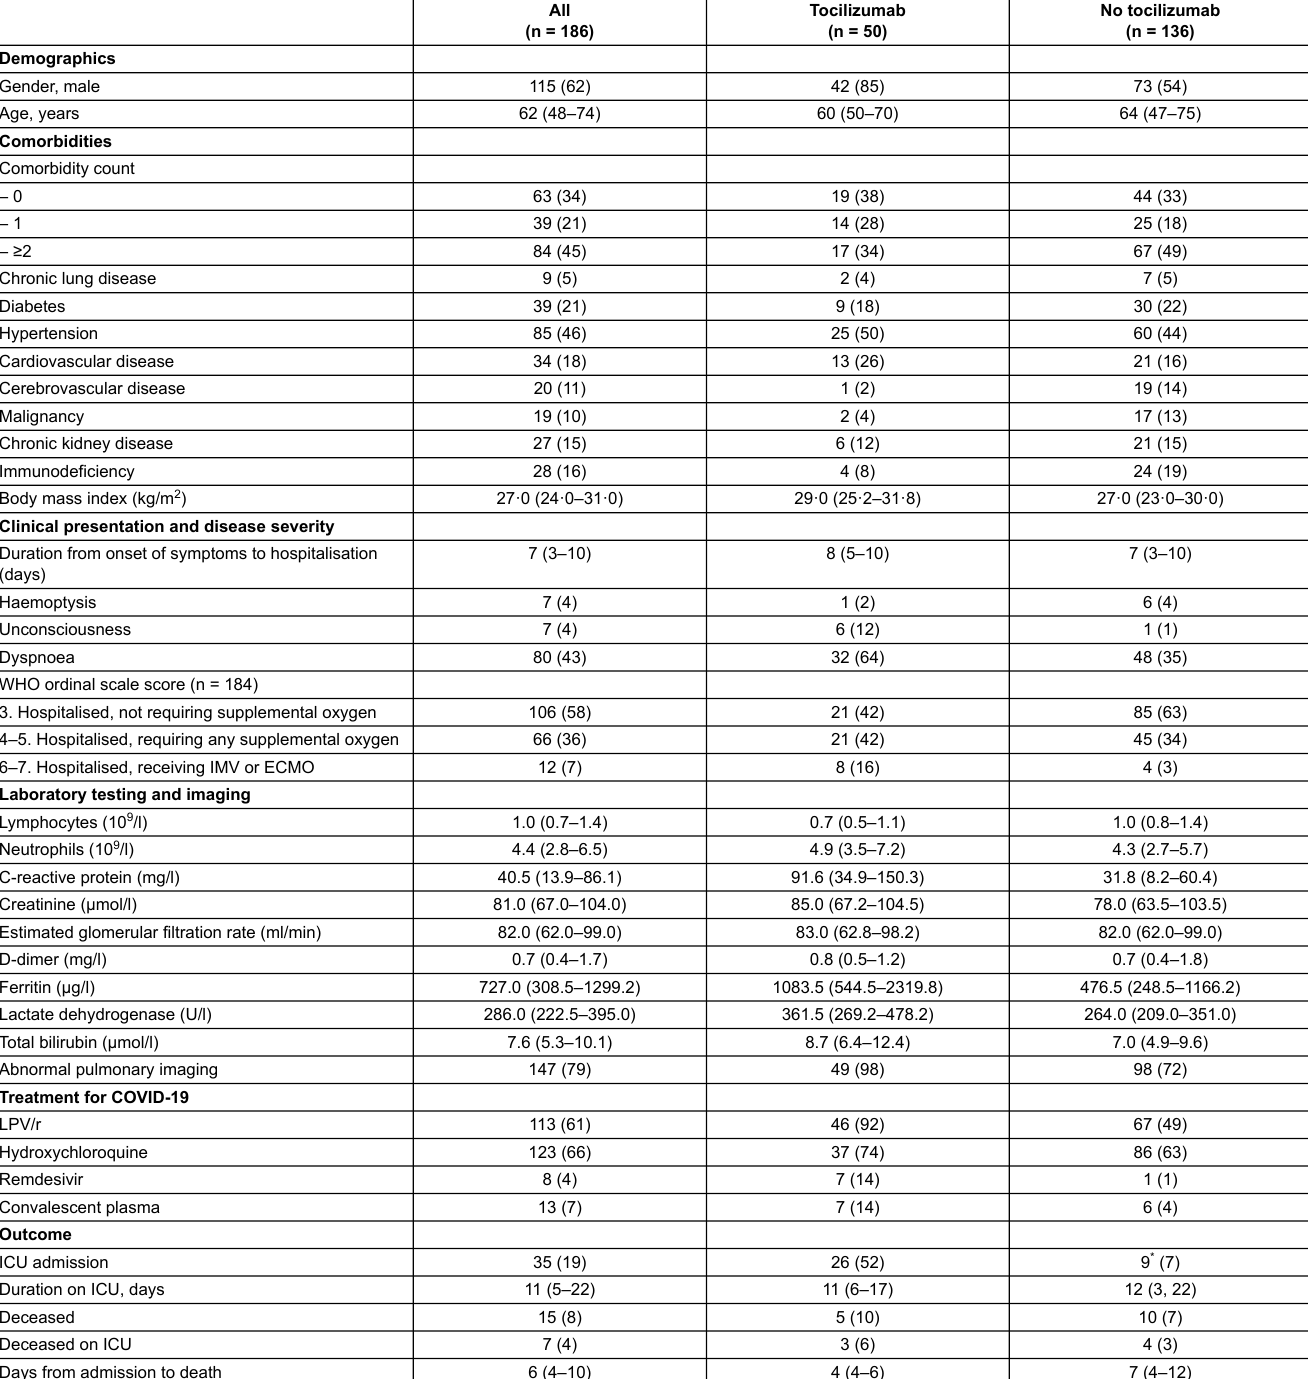
Table S1: Demographic characteristics and underlying comorbidities of all COVID-19 patients who met the inclusion